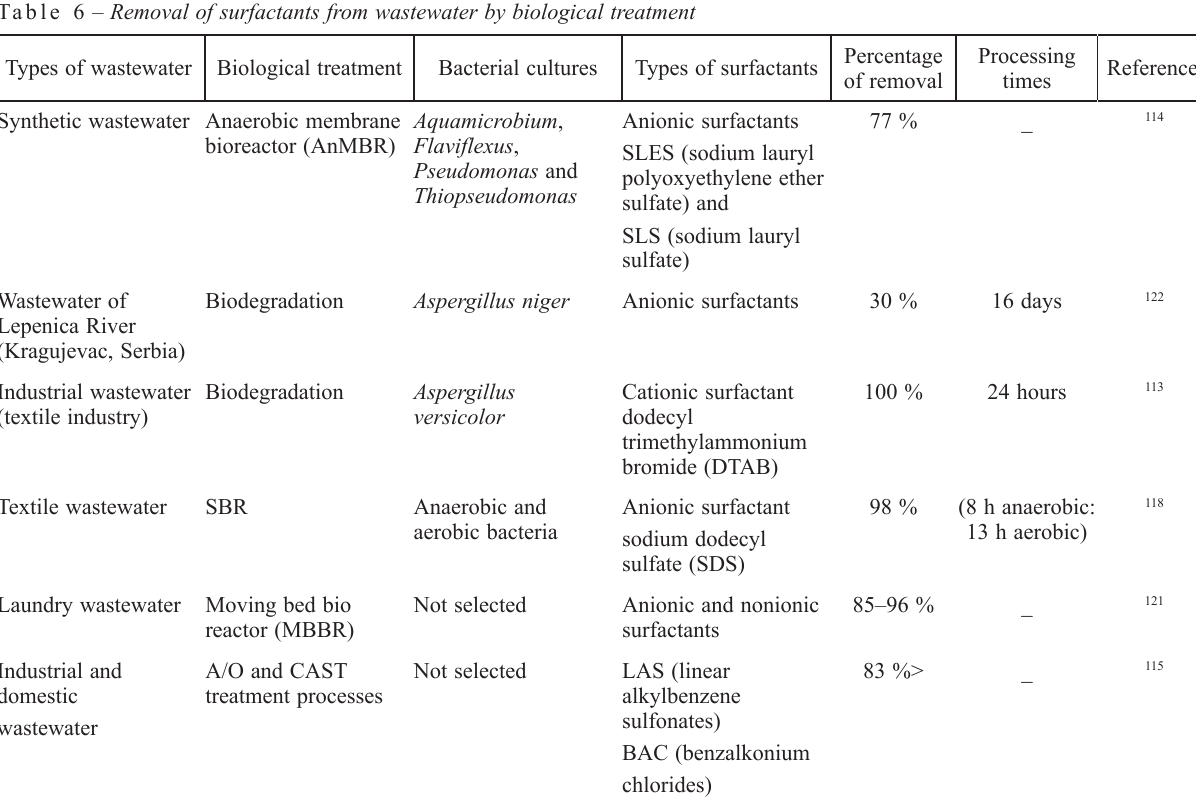
Table 6 – Removal of surfactants from wastewater by biological treatment Types of wastewater Biological